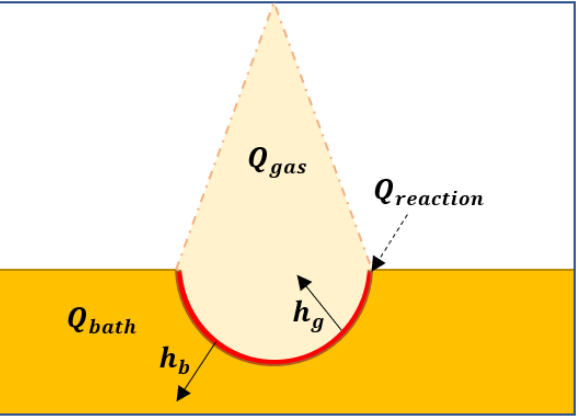
Figure 3. A schematic representing the heat transfer from a hot spot